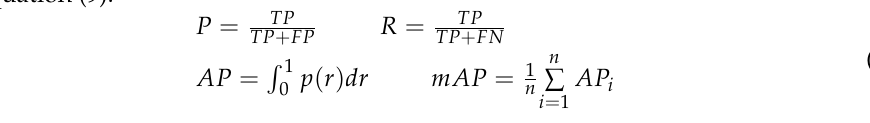
Figure 14. Test accuracy ( a ) and loss ( b ) curves for the proposed method and the yolo family of detection algorithms in the DR datasets.